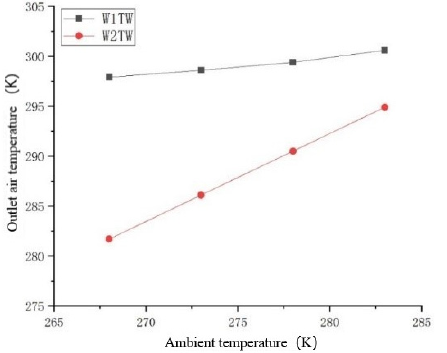
Figure 7. The changing of the outlet air temperature with the ambient temperature.